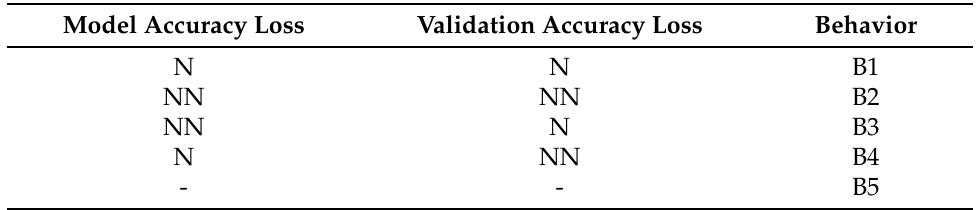
Table 6. Behavior activity for estimation of the applicability of the model to the dataset for Case Study II. N means accuracy vs. epoch dependence corresponds to the normal one (Figure 6a), NN means irregular behavior (Figure 6b), ’-’ means accuracy is zero.